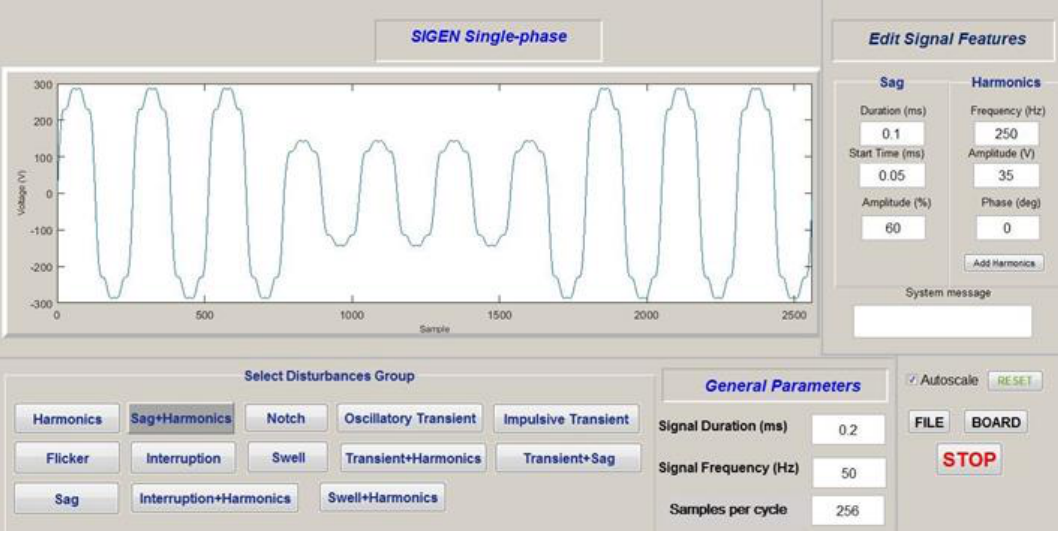
Figure 5. Graphical interface of signal generator SIGEN.